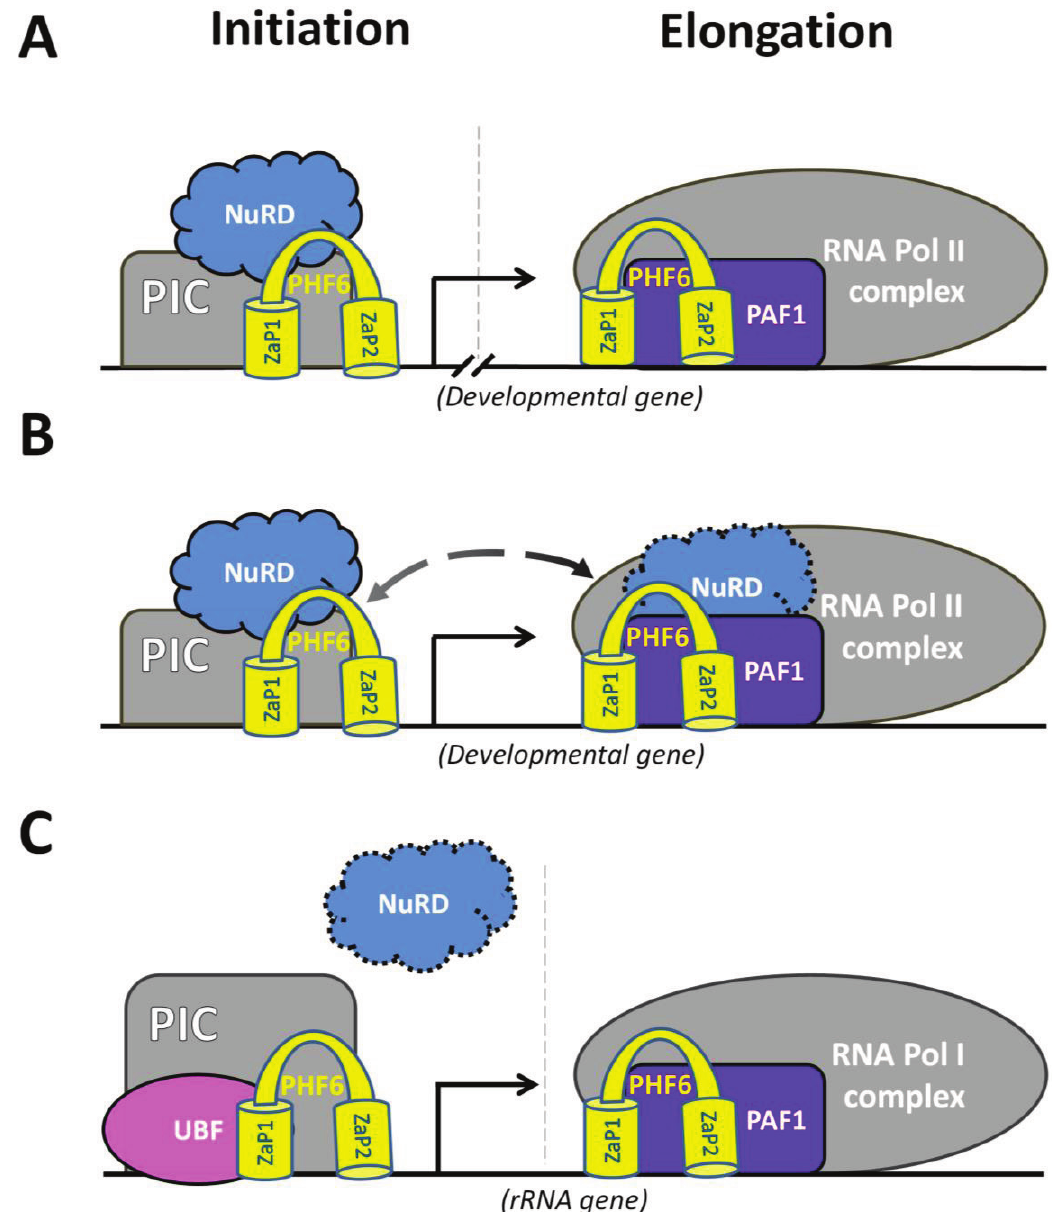
Figure 4. Model for PHF6-dependent transcriptional regulation at developmental or rDNA gene targets. ( A ) At developmental genes, PHF6 recruits NuRD to promoters to either activate or repress transcription. Similarly, PHF6 can regulate transcriptional elongation at developmental genes through its interaction with the PAF1 complex. ( B ) Another possible mechanism is that PHF6 interactions with NuRD and PAF1 occur at the same gene whereby PHF6 promotes the formation of a NuRD-PAF1 supercomplex to allow for productive elongation. The existence of a PHF6-mediated supercomplex would be analogous to an IKAROS-driven complex previously described [119]. ( C ) At rRNA genes, PHF6 interacts with UBF to mediate the initiation of rRNA transcription (left). Promoter regulation may also involve NuRD, although this remains to be shown. Similarly, PHF6-PAF1 may mediate rRNA transcriptional elongation, although experimental validation is still